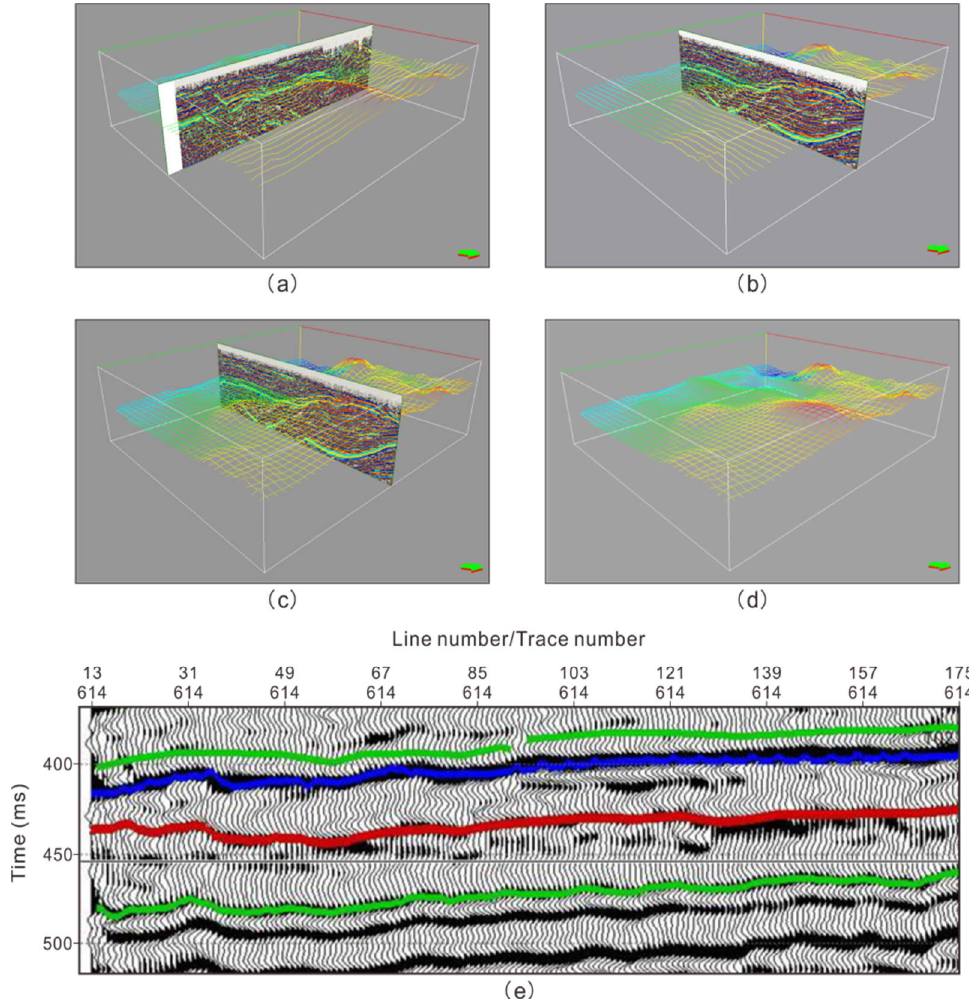
Figure 3. An example of seismic horizon tracking result. ( a ) The horizon tracking result along the inline direction, ( b ) The horizon tracking along the cross-line direction, ( c ) The cross closure check, ( d ) The final output result of the horizon tracking, ( e ) The range of horizon tracking result determined by the obvious standard interface.